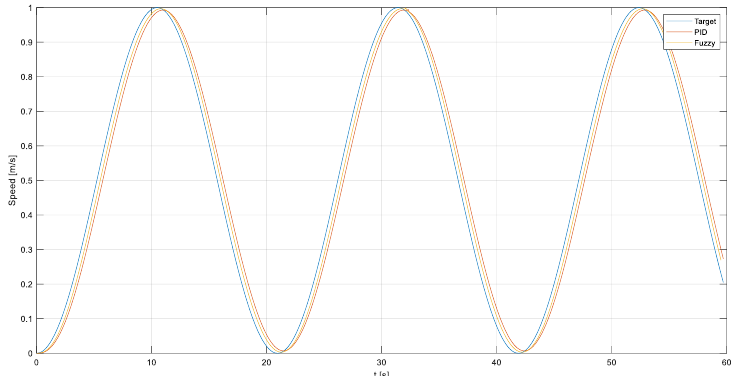
Figure 23. Comparison of speed tracking provided by a PLC and a FLC controller.